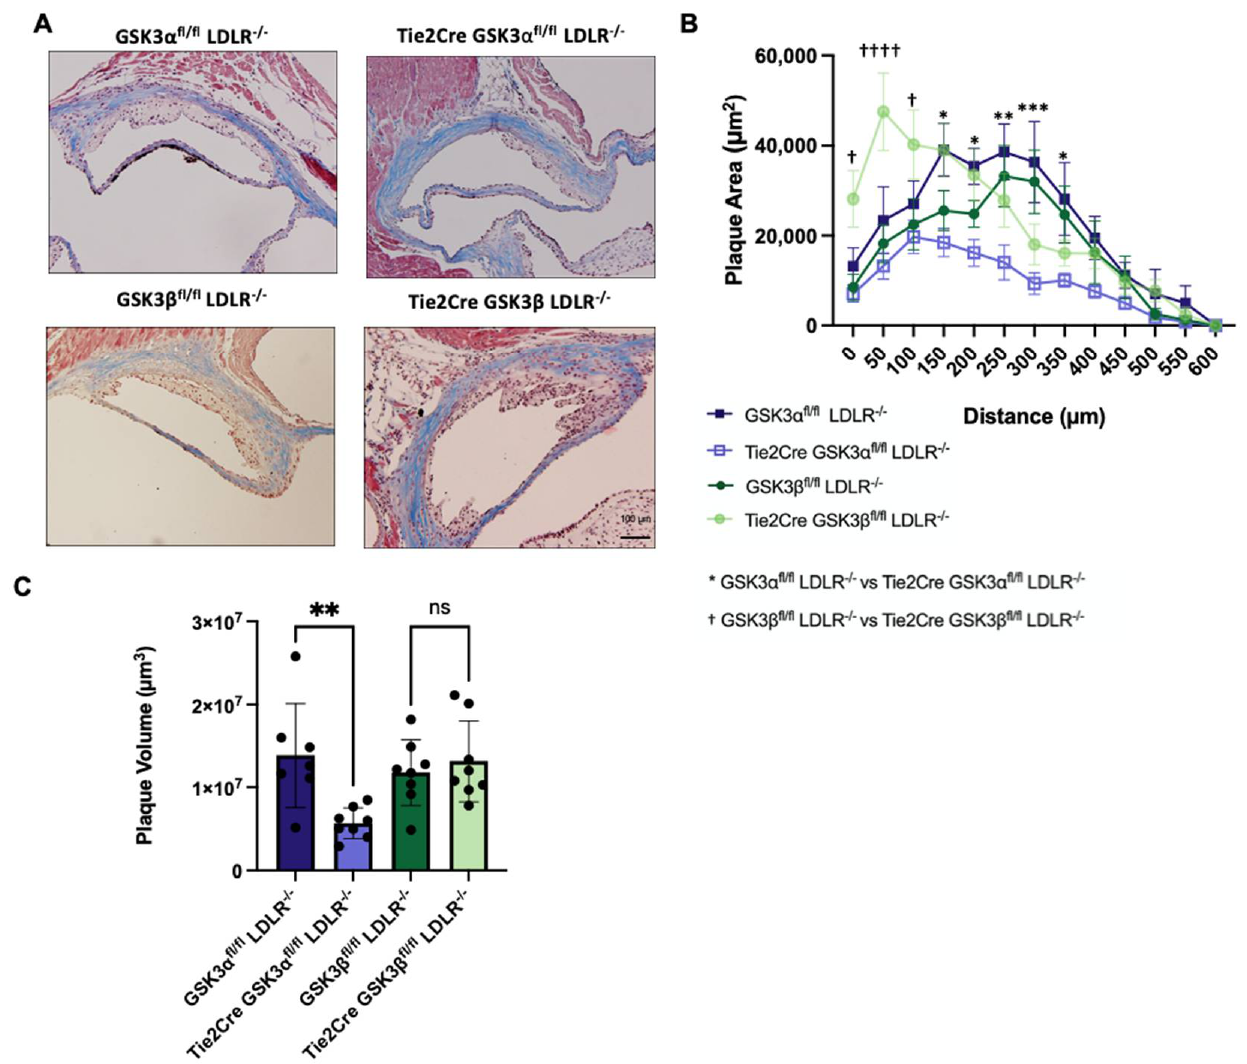
Figure 1. Atherosclerosis in endothelial/macrophage GSK3 α / β knockout mice. ( A ) Representative images of Masson’s trichrome staining of cross sections of aortic sinus from 15 week old control or endothelial/macrophage GSK3 α / β knockout mice. Scale bar represents 100 µ m. ( B ) Quantification of plaque area at the aortic sinus of the 15 week old mice. ( C ) Plaque volume quantification in the aortic sinus of control and endothelial/macrophage GSK3 α / β knockout mice. n = 7–8 ( B , C ), * p < 0.05, ** p < 0.005, *** p < 0.0005, † p < 0.05, †††† p < 0.00005, ns = not significant. Sections were stained with an antibody against CD107b + /Mac-3 + (Mac-3) to assess monocyte/macrophage recruitment. Tie2Cre GSK3 α fl/fl LDLR − / − mice had significantly reduced Mac-3 staining, compared to age matched control mice (Figure 3). There was no sig- nificant difference in monocyte/macrophage content between Tie2Cre GSK3 β fl/fl LDLR − / − and GSK3 β fl/fl LDLR − / − control mice, these findings support a role for endothelial and macrophage GSK3 α in monocyte/macrophage